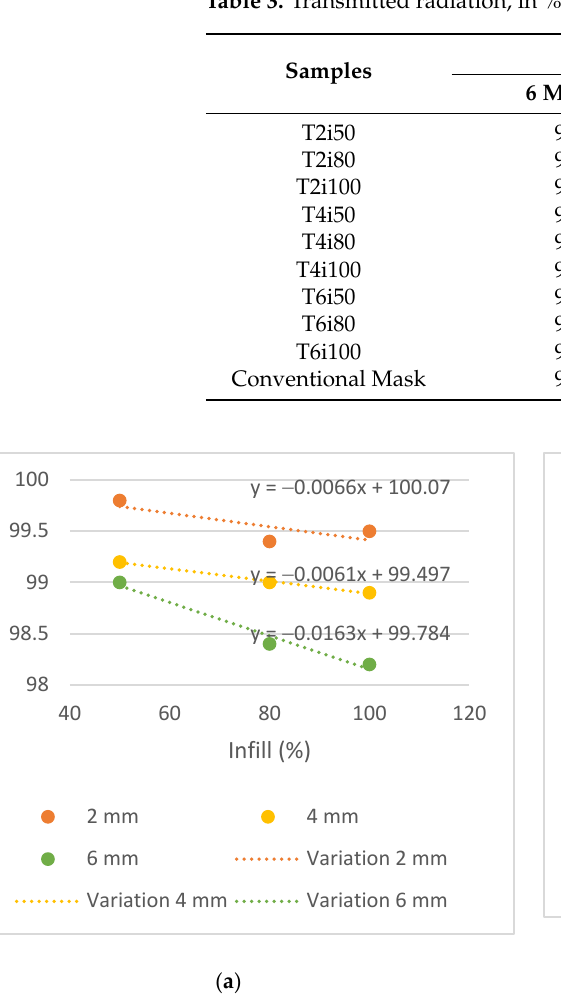
Table 3. Transmitted radiation, in %, through the different PLA plates.